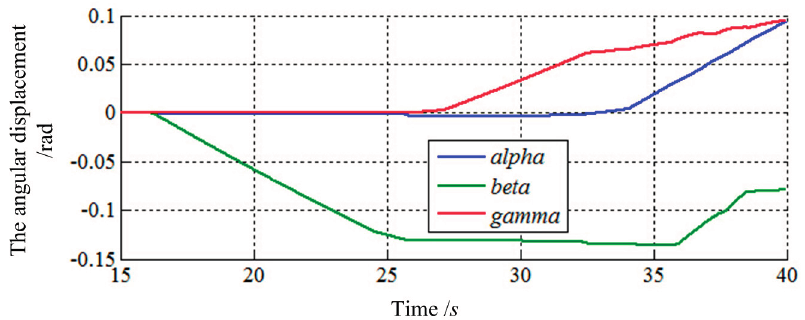
Figure 23. The angular displacement of load sensing ring based on Equation